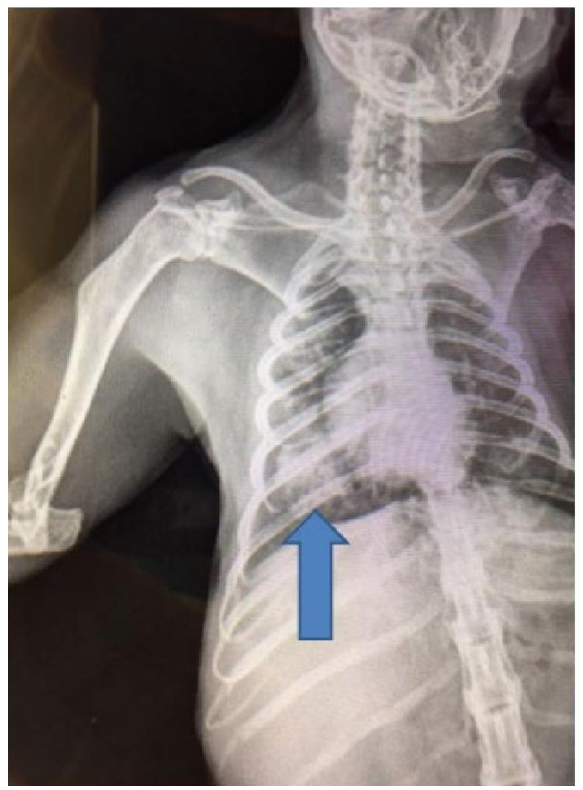
Fig 2. Chest radiograph prior to necropsy from marmoset #2 showing a superior segment right lower lobe infiltrate. Right lower lobe consolidation with numerous granulomas were confirmed on histologic exam.